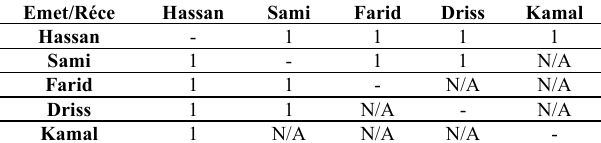
Case 3: Sharing a publication as "link" type, as described in Table X. When Hassan shared a publication he had some interactions from his friends (Sami Farid, Driss and Kamal), the same happened for the other users. So the total of interactions is 12 on 12, which mean 100% of the expected interactions.